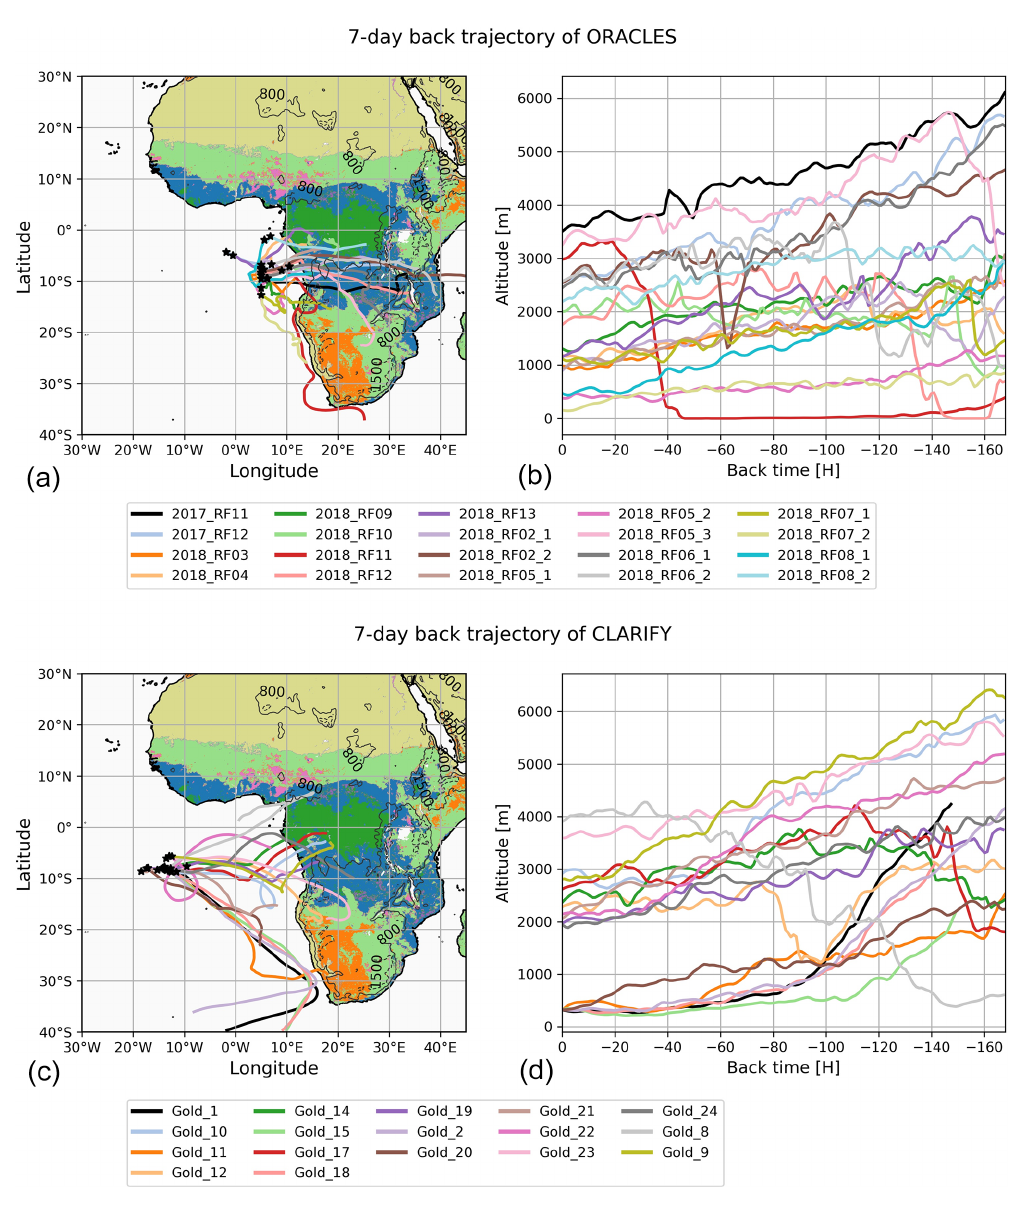
Figure 1. The location of filter sampling and back trajectories related to each filter, including altitude for ORACLES 2017–2018 (a, b) and CLARIFY 2017 (c, d) . Map colors relate to MODIS land cover